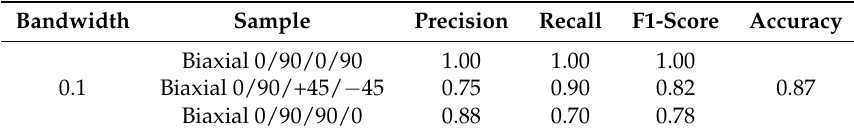
Figure 8. Confusion matrix for synthetically created double thickness samples with 0.1 bandwidth random point of Gaussian normal added for noise MSE when compared to KDE / t . Table 4. Classification report for double thickness synthetic sample, with addition of random Gaussian normal noise bandwidth